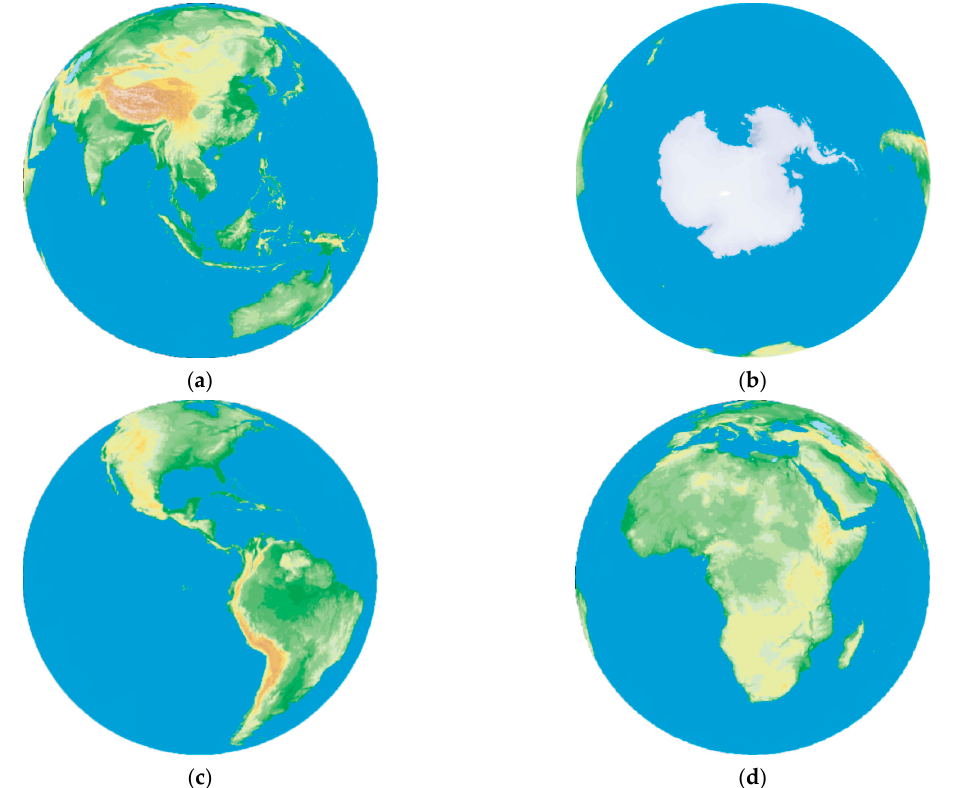
Figure 13. Resampling results of the GTOPO30 DEM dataset based on the proposed scheme: The four figures are different views of the globe: ( a ) Europe and Asia; ( b ) Antarctica; ( c ) North America and South America; ( d ) Africa (source—own study).